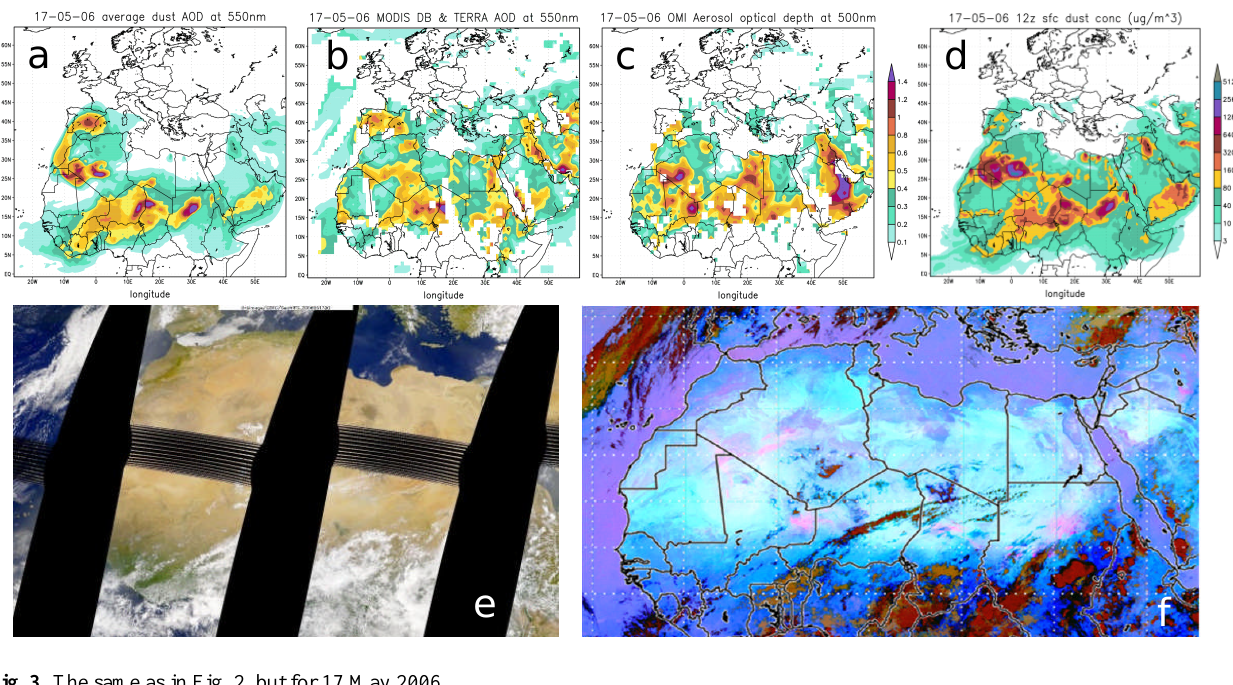
Fig. 3. The same as in Fig. 2, but for 17 May 2006.